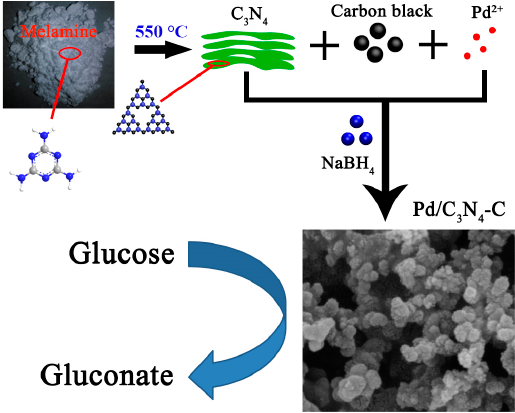
Figure 8. Schematic depiction of the formation of porous Pd/C 3 N 4 -C.